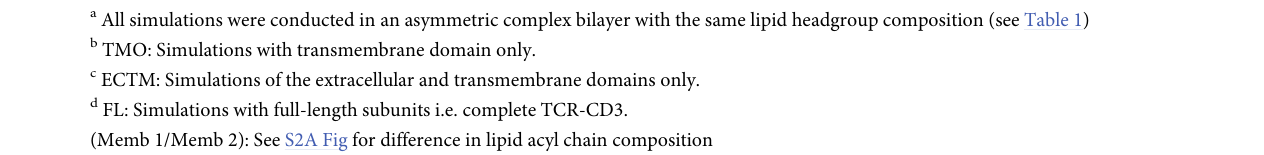
TMO: Simulations with transmembrane domain only. c